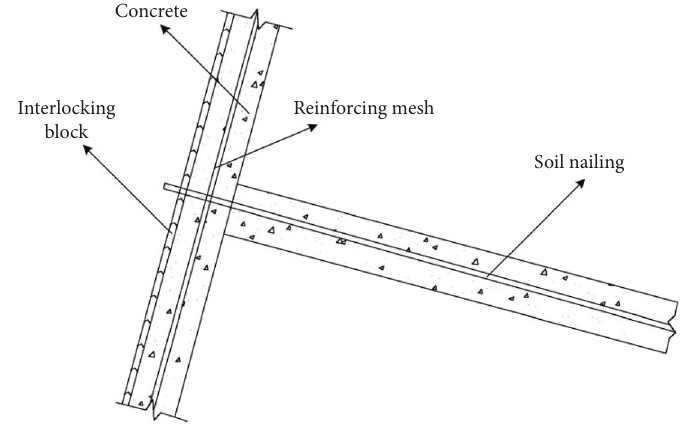
Figure 9: Schematic diagram of soil nail structure.